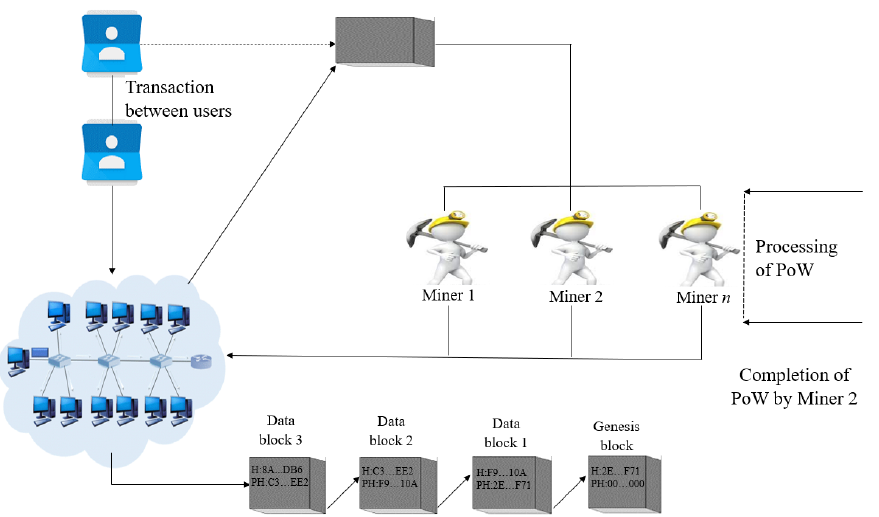
Figure 2. Workflow in the proposed